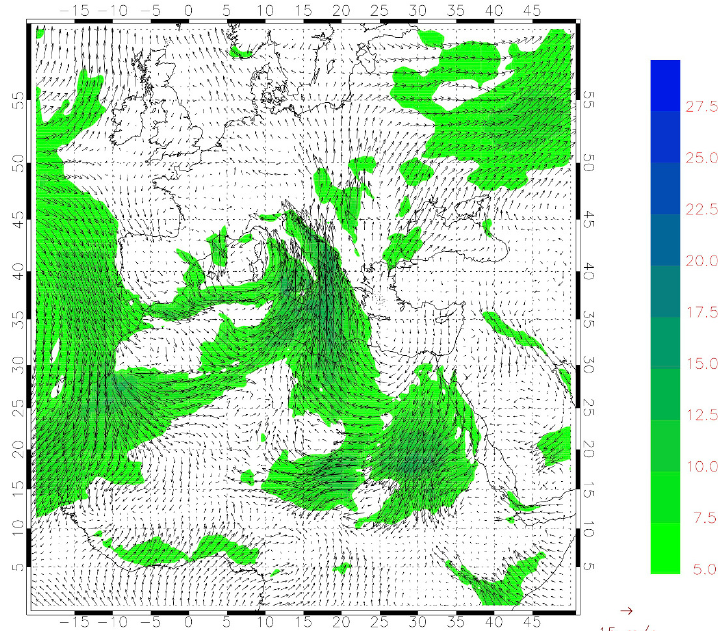
Figure 4. Averaged (at 00 UTC for the selected 15 “dust events”) wind speed (shaded contours; m/s) and direction (vector) at 925 hPa. The maps are generated using Copernicus Climate-Change Service Information